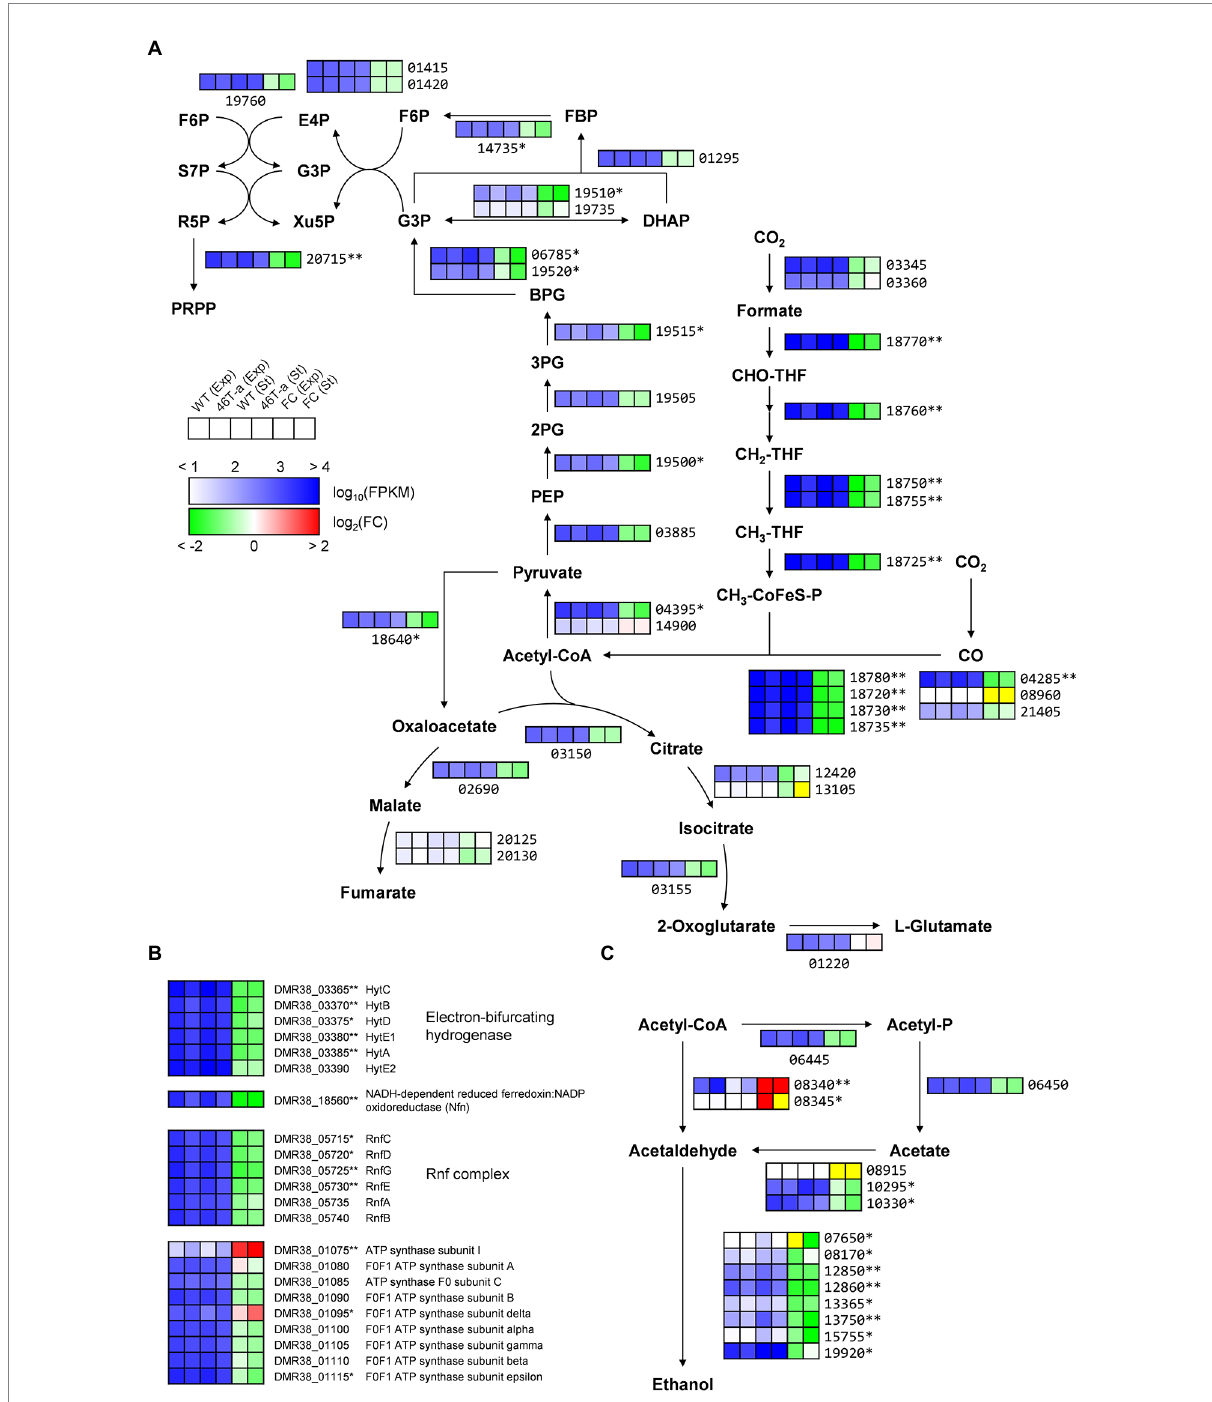
FIGURE 5 Transcription profiles of central metabolic pathways in AWRP and 46 T-a. (A) Shown are central carbon metabolism including the Wood-Ljungdahl pathway, glycolysis/gluconeogenesis, pentose phosphate pathway, and bifurcating TCA cycle. (B) Shown are genes involved in electron transfer and ATP synthesis. (C) Shown are genes involved in acetate and ethanol production. Transcription levels (represented as Fragments Per Kilobase Million [FPKM]) and fold changes for each gene are shown as a six-column heatmap. From left to right, the first 4 boxes show the log 10 (FPKM) value of AWRP in exponential phase (Exp), 46 T-a (Exp), AWRP in stationary phase (St), and 46 T-a (St). The right two boxes show the fold change (FC) of exponential and stationary phase expressed as log 2 (FPKM 46T-a /FPKM AWRP ). The yellow color in the fold change box indicates that the fold change value might not be valid because both FPKM values were too low (<10). The gene’s locus tag is located to the right or below the heatmap box (prefixes are omitted in panels A , C for simplicity). Single and double asterisks next to the locus tag indicate differential expression with statistical significance (|log 2 (folds)| > 1 and FDR < 0.001) in one and two phases,